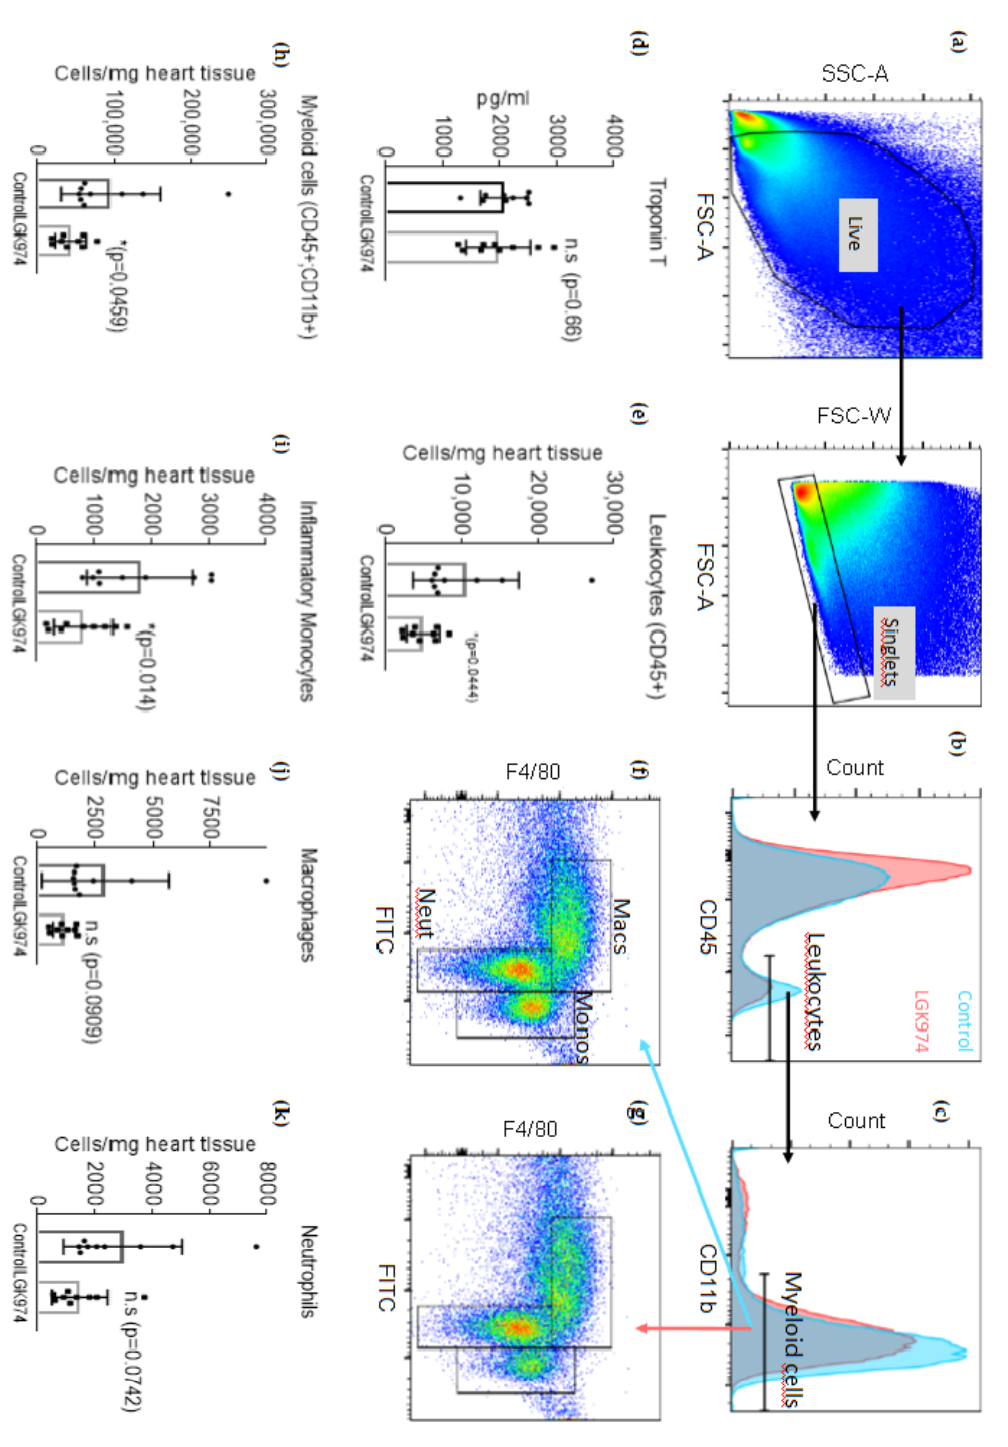
Figure 3. LGK-974 treatment alters the inflammatory response following I/R injury. ( a ) Gating scheme excluding dead cells, cell debris, and doublets. ( b , c ) representative histogram of heart tissue leukocytes resp. myeloid cells 2 days after I/R injury. ( d ) Quantification of total leukocytes in heart tissue following I/R injury. ( e ) Quantification of myeloid cells in the heart following I/R injury. ( f ) and ( g ) representative images of flow cytometric analysis of heart tissue cell suspension following I/R injury in DMSO resp. LGK-974 treated animals on monocytes, macrophages, and neutrophils. ( h – j ) quantification of inflammatory monocytes, macrophages, and neutrophils two days after I/R injury. ( k ) cardiac troponin T plasma levels 24 h after I/R injury. N = 9 per group.